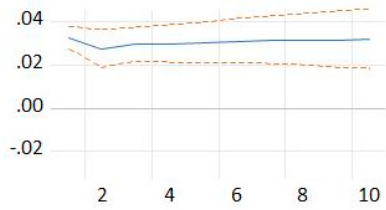
Figure 8. Response of persons employed in the population of actives enterprises to a shock from: persons employed in the population of active enterprises. Source: the authors’ own computations.